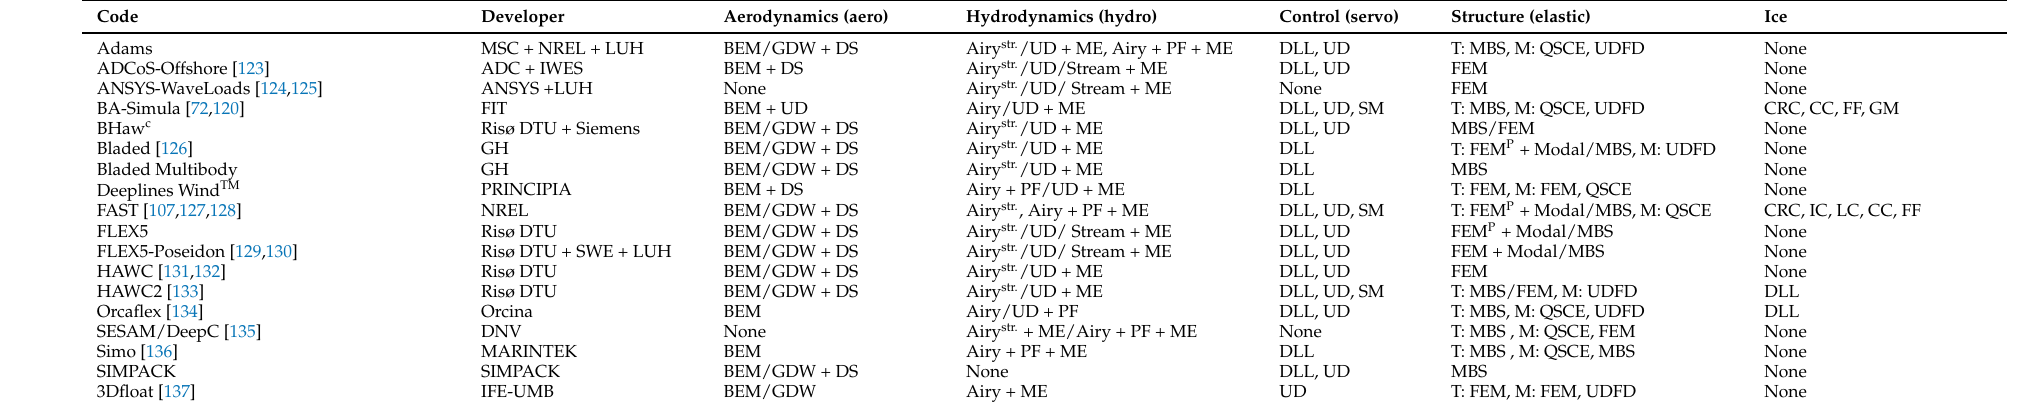
Table 1. Overview of aero-servo-hydro-elastic numerical models and their capabilities and